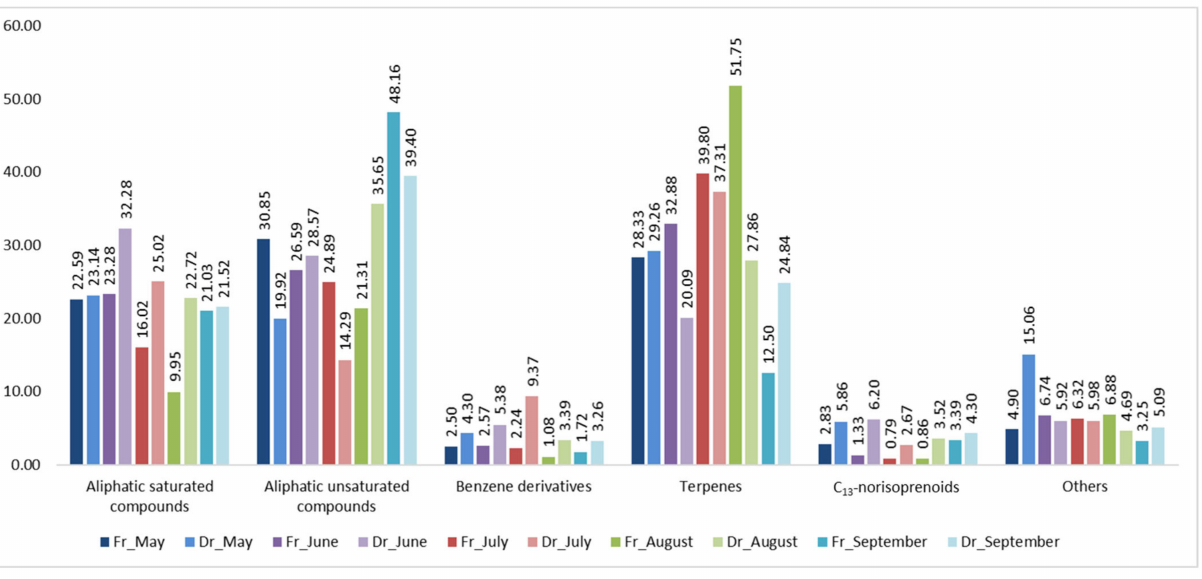
Figure 7. The VOCs from H. scoparia sorted by structural groups obtained by hydrodistillation (HD) and analysed by gas chromatography–mass spectrometry (GC–MS); Fr (fresh), Dr (dry). Among aliphatic compounds, the dominant was unsaturated pentadec-1-ene with its peak in September in both HD-FrHSc (26.46%) and HD-DrHSc (18.98%). Higher aliphatic unsaturated alcohol ( Z,Z,Z )-octadeca-9,12,15-trien-1-ol was prevalent in HD-FrHSc in May (8.09%) and decreased each month. Higher aliphatic unsaturated aldehyde ( Z )-octadec- 9-enal was the most abundant in HD-FrHSc in August (8.51%). Both the alcohol and the aldehyde were less abundant in air-dried samples throughout all the months since lipid oxidative degradation probably occurred, which means they were oxidised and further degraded. Six carboxylic acids were detected and identified with hexanoic acid as the most abundant one particularly in HD-DrHSc in May (4.80%). Three C 13 -norisoprenoids were detected, among which β -ionone was the most abundant. It was higher in air-dried samples, which was the result of carotenoid degradation during the process of